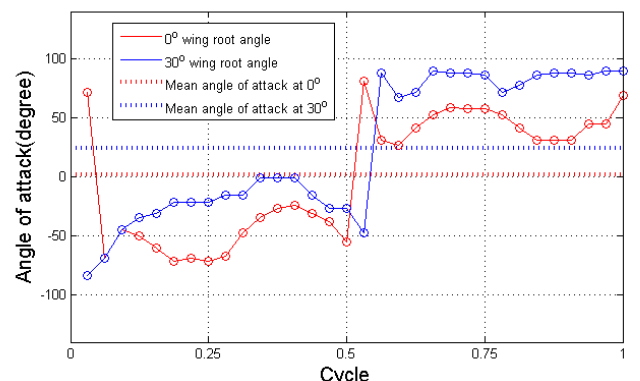
Figure 18. The measured angles of attack.